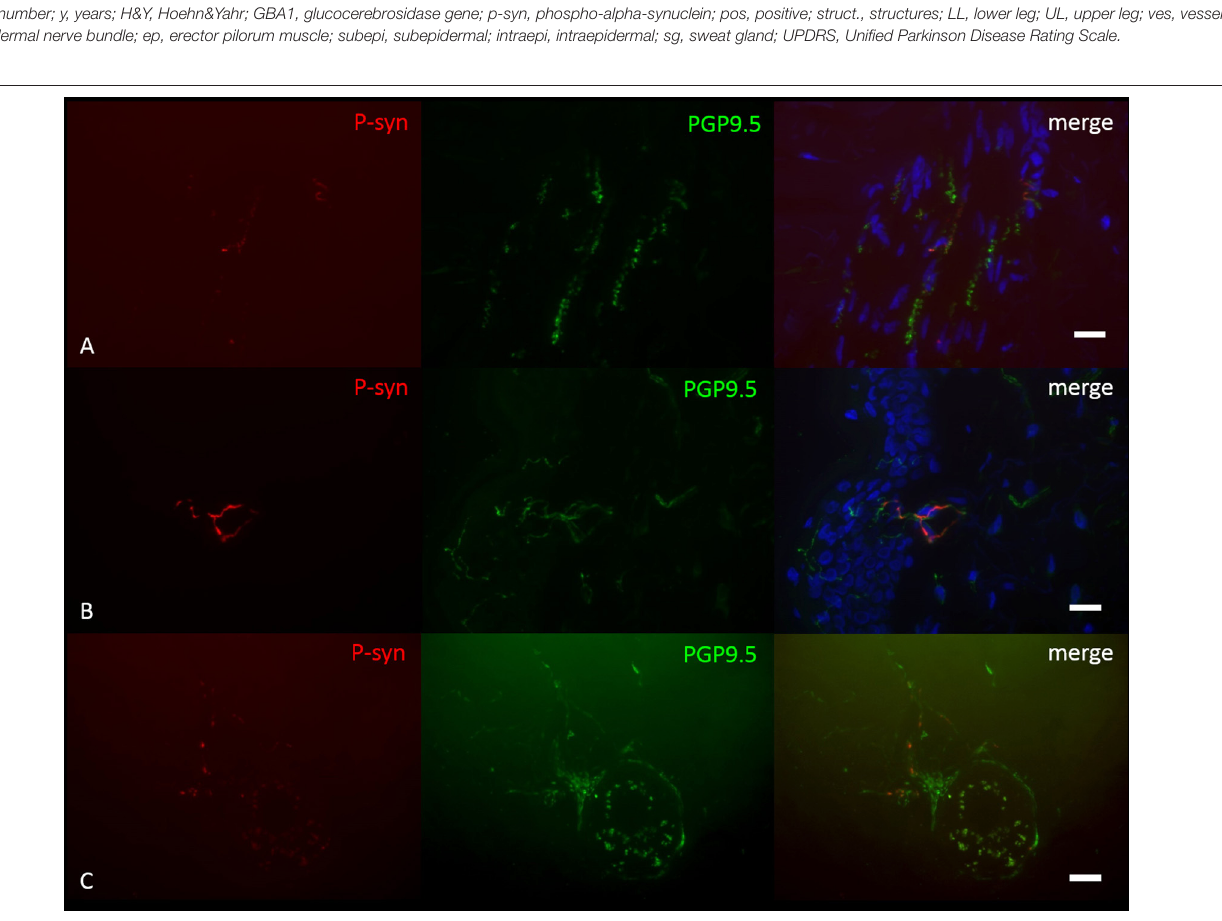
FIGURE 1 | Photomicrographs of a double-immunofluorescence staining with anti-p-syn (red) and anti-PGP9.5 (green). Cell nuclei are stained with DAPI (blue). P-syn deposition is detectable in pilomotor fibers (A) , intraepidermal fibers (B) and sudomotor fibers (C) of patients with GBA1 mutation-associated PD. Scale Bar = 10 µ